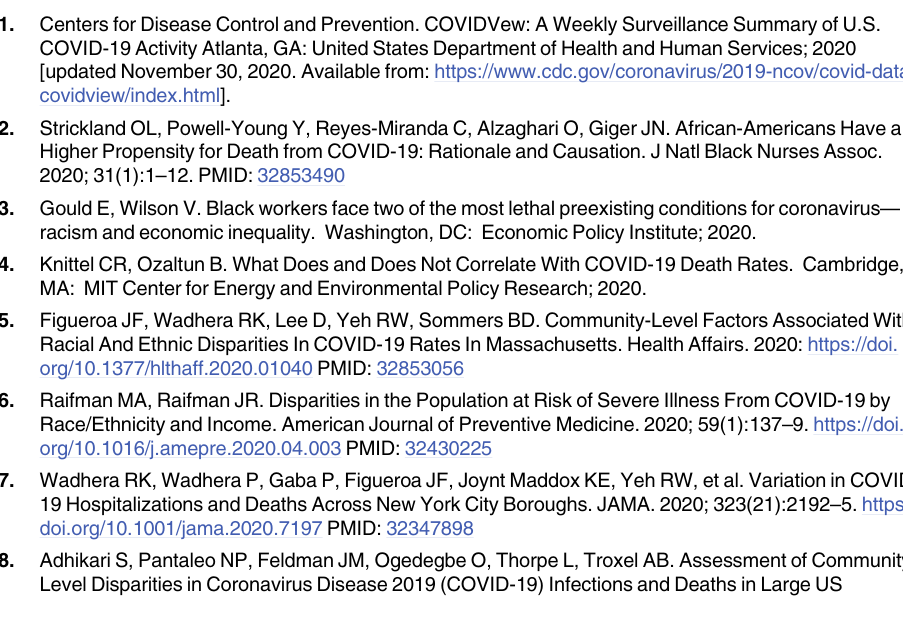
S1 Fig. Flow diagram of patient inclusion and exclusion. Abbreviations: MO = Missouri; MO DHSS = Missouri Department of Health and Social Services. S1 Table. Further breakdown of “Other” race category. Numbers represent hospital claims rather than unique individuals, since patients could have one race reported on one claim and a different one reported on another claim. If a patient had an even number of claims with two different races (for example, two with White and two with Asian), he or she was left in the “other” category because we could not determine which was the appropriate category. S2 Table. Impact of additional adjustment on ICC associated with race variable. Abbrevia- tions: ICC, intraclass coefficient; SDOH, social determinants of health; SE, standard